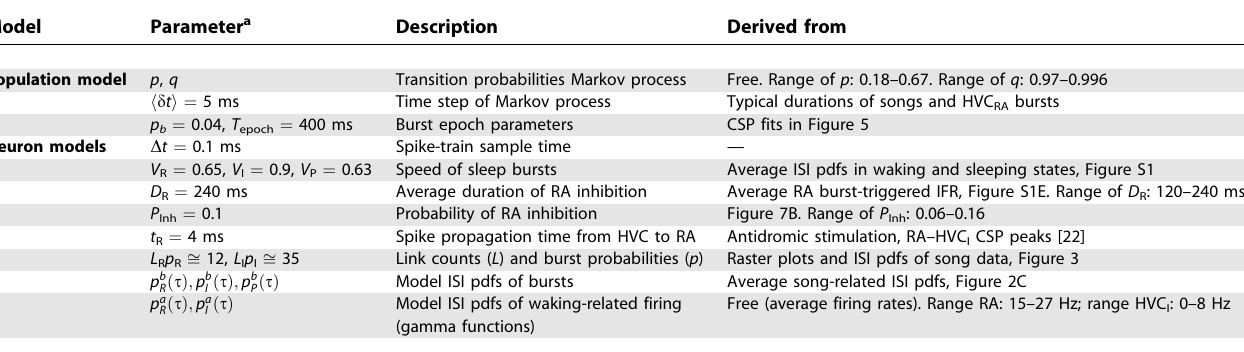
Table 1. Model Parameters and Their Derivation Model Parameter a Description Derived from